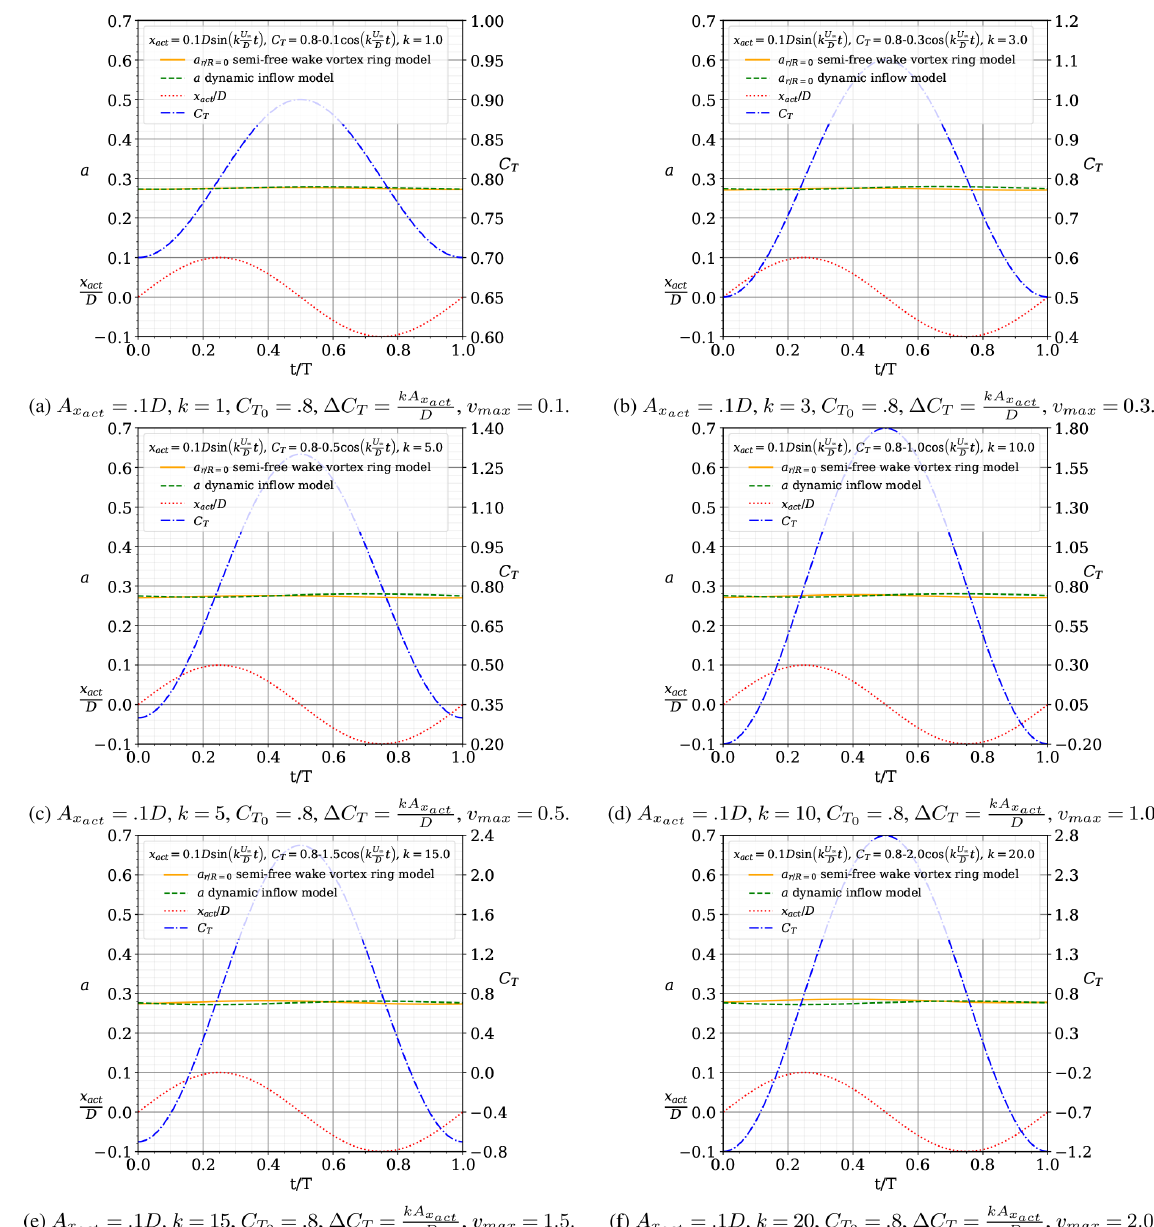
Figure 6. Comparison of the results of induction by the semi-free-wake vortex ring model and the proposed dynamic inflow model at the centre of the actuator r/R = 0 for a sinusoidal surge motion with x act = A x (cid:49)C T cos( kU ∞ /Dt ) (also plotted). The results are plotted over one period, along the non-dimensional time t/T . These cases are defined kA x act by (cid:49)C T = D